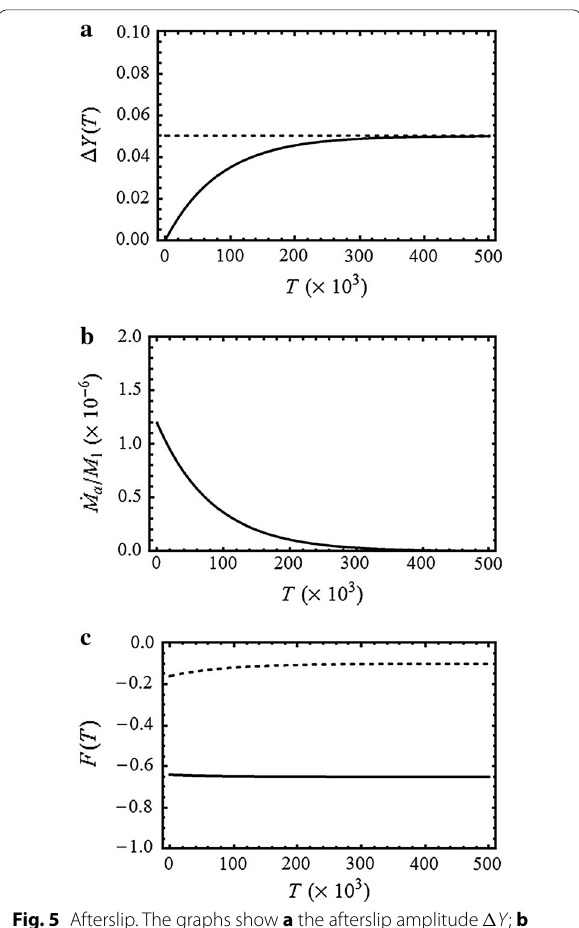
Fig. 5 Afterslip. The graphs show a the afterslip amplitude (cid:31) Y ; b the associated moment rate M a ; c the forces F 1 (solid) and F 2 (dashed) on the asperity and on the weak region, respectively, as functions of nondimensional time